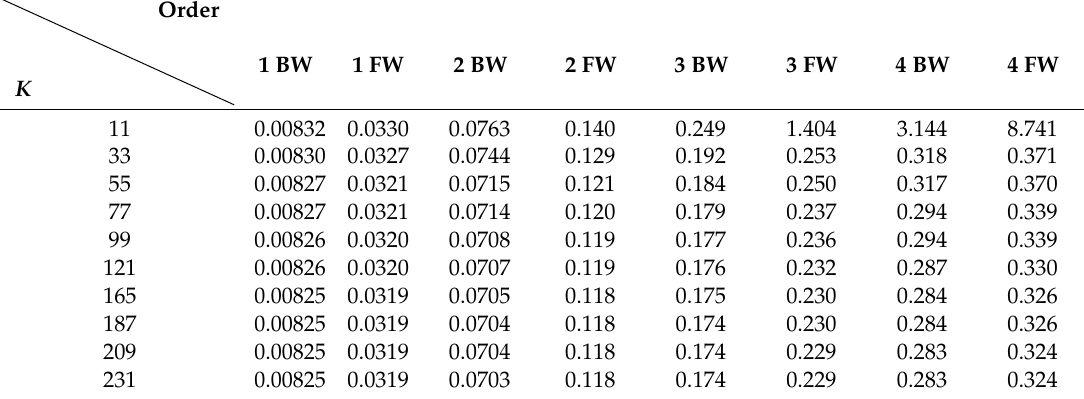
Table 6. Natural frequencies via modal discretization ( h = 500 Nms).